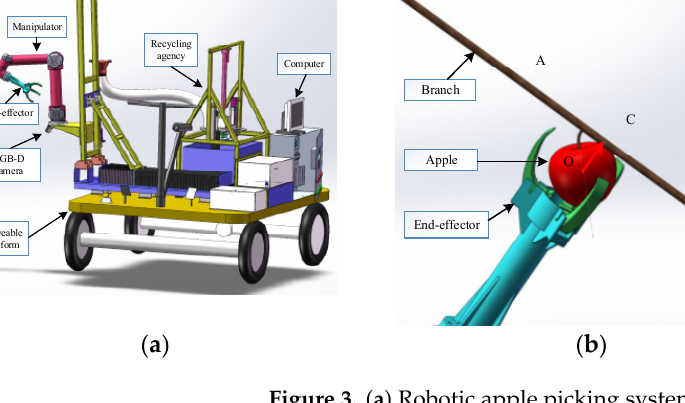
Figure 3. ( a ) Robotic apple picking system; ( b ) picking orientation ( A and B are two points on the branch, O is the center of mass of the apple, C is a point on the branch, and AB is perpendicular to OC , and OC is the picking direction); ( c ) robot picking track.